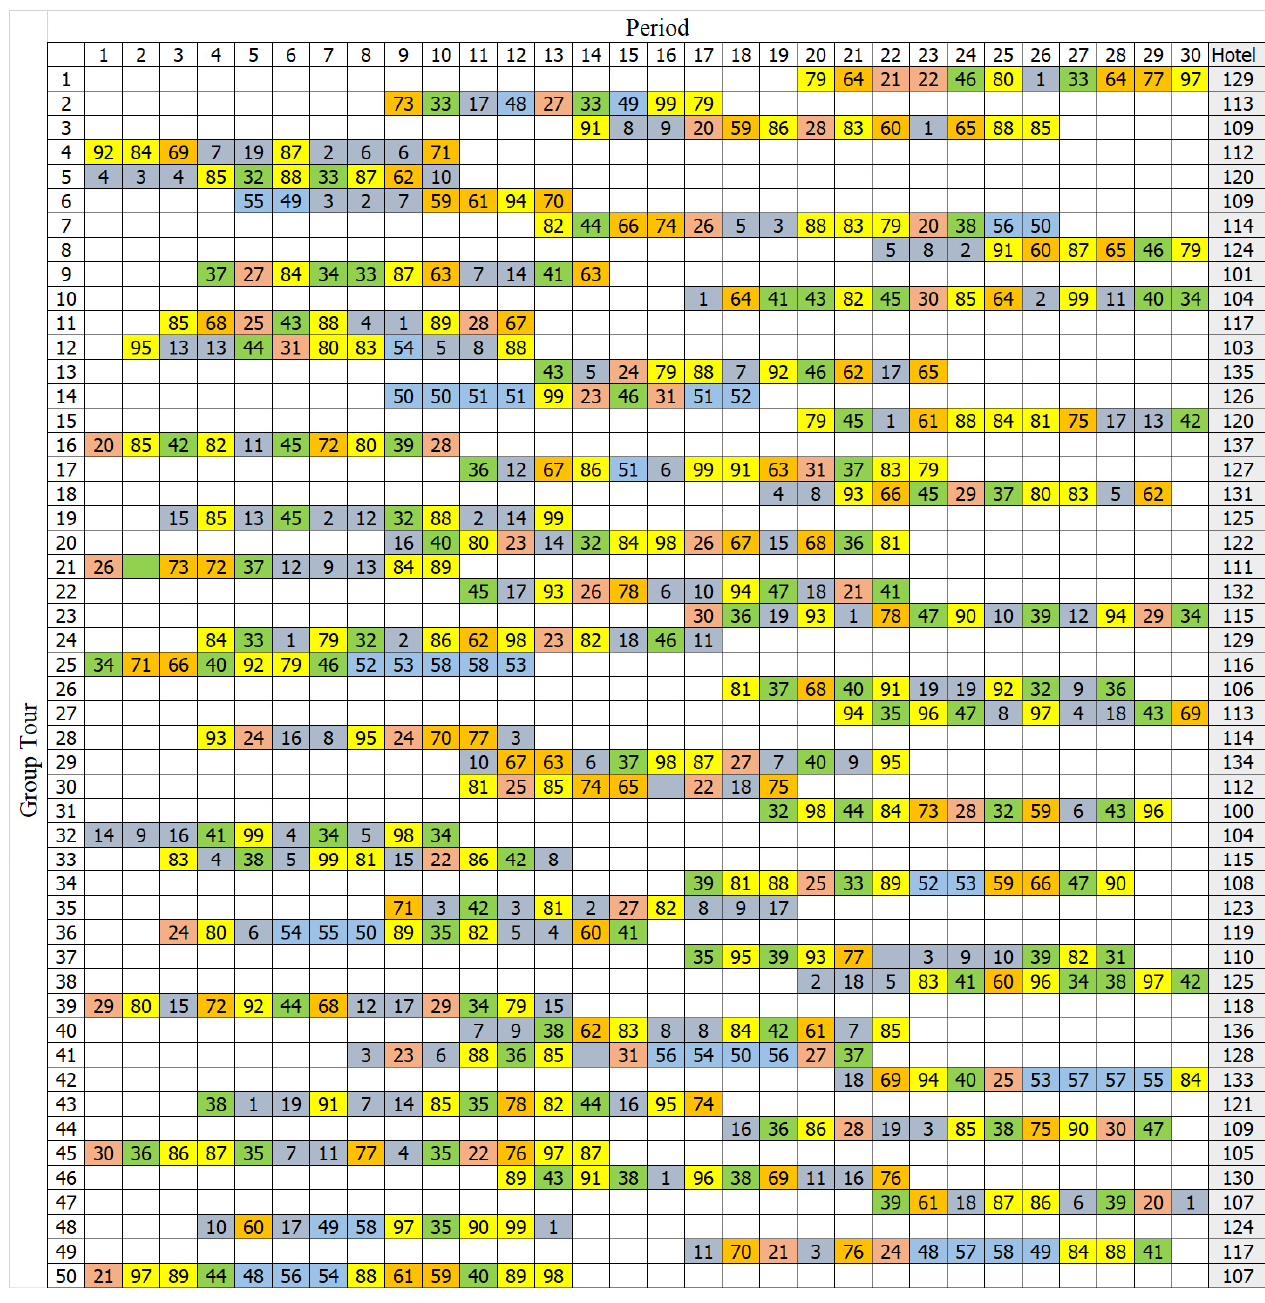
Figure 6. Assignment of the case study results (Gantt chart of the group tour).